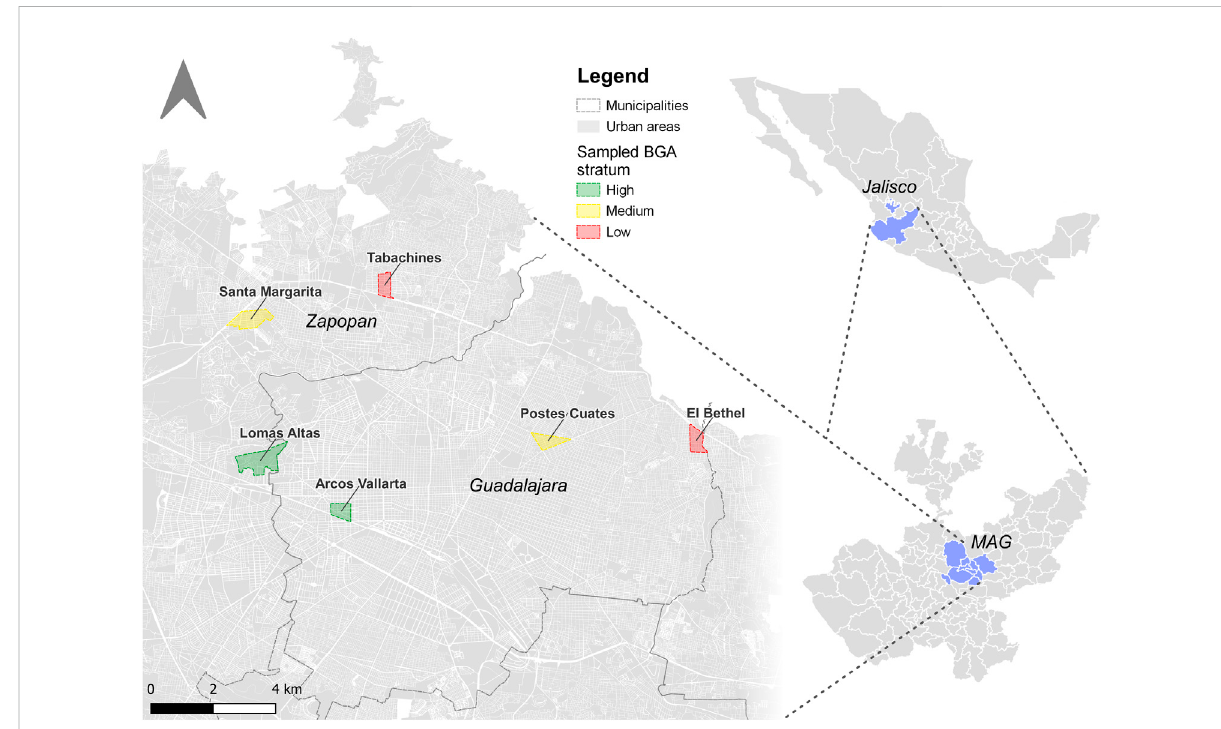
FIGURE 1 Map of selected BGAs in Zapopan and Guadalajara for the strati fi ed sampling of the